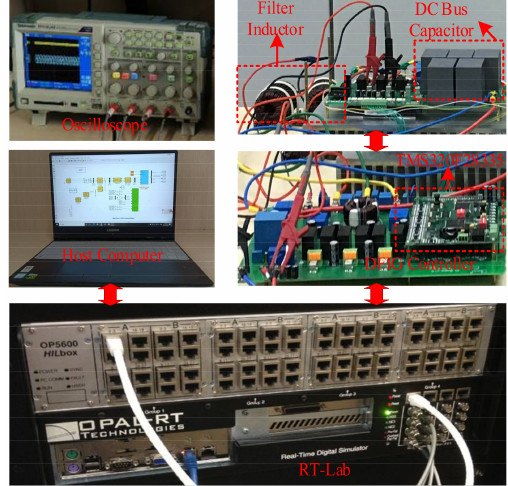
Figure 7. Impedance curves with different current control ( Z Z sequence perturbation without frequency coupling. Z T is the entire impedance of DFIG system considering the cross-coupling term).